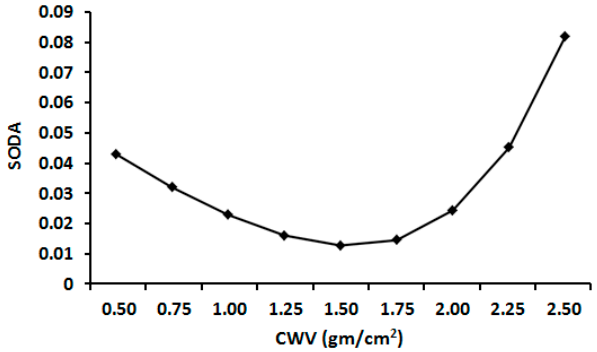
Figure 6. SODA 2 H O smoothness values of reflectance curve indices that are insensitive to CWV. The best estimate of CWV occurs at the minimum SODA 2 H O value.